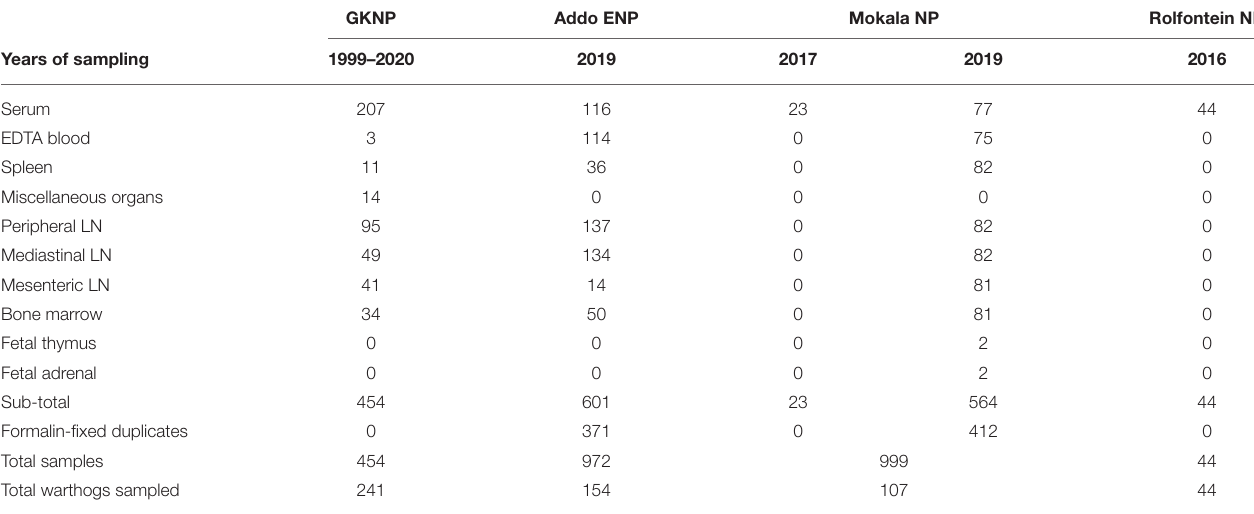
TABLE 1 | Samples obtained from warthogs in four nature reserves in South Africa (abbreviations as given in the text). GKNP Addo ENP Mokala NP Rolfontein NR Years of